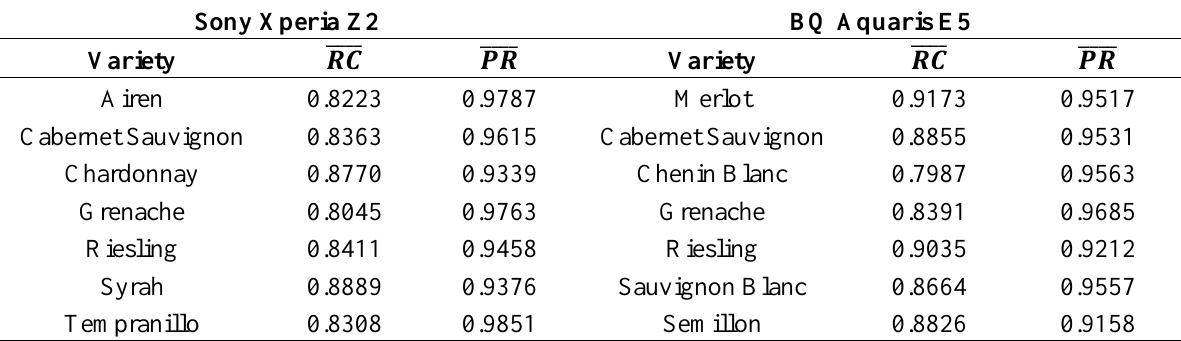
Table 3. Performance evaluation of vitisFlower ® using 2 different devices. The average Recall ( 𝑅𝐶̅̅̅̅ ) and Precision ( 𝑃𝑅̅̅̅̅ ) calculated from the 10 images in each grapevine variety are